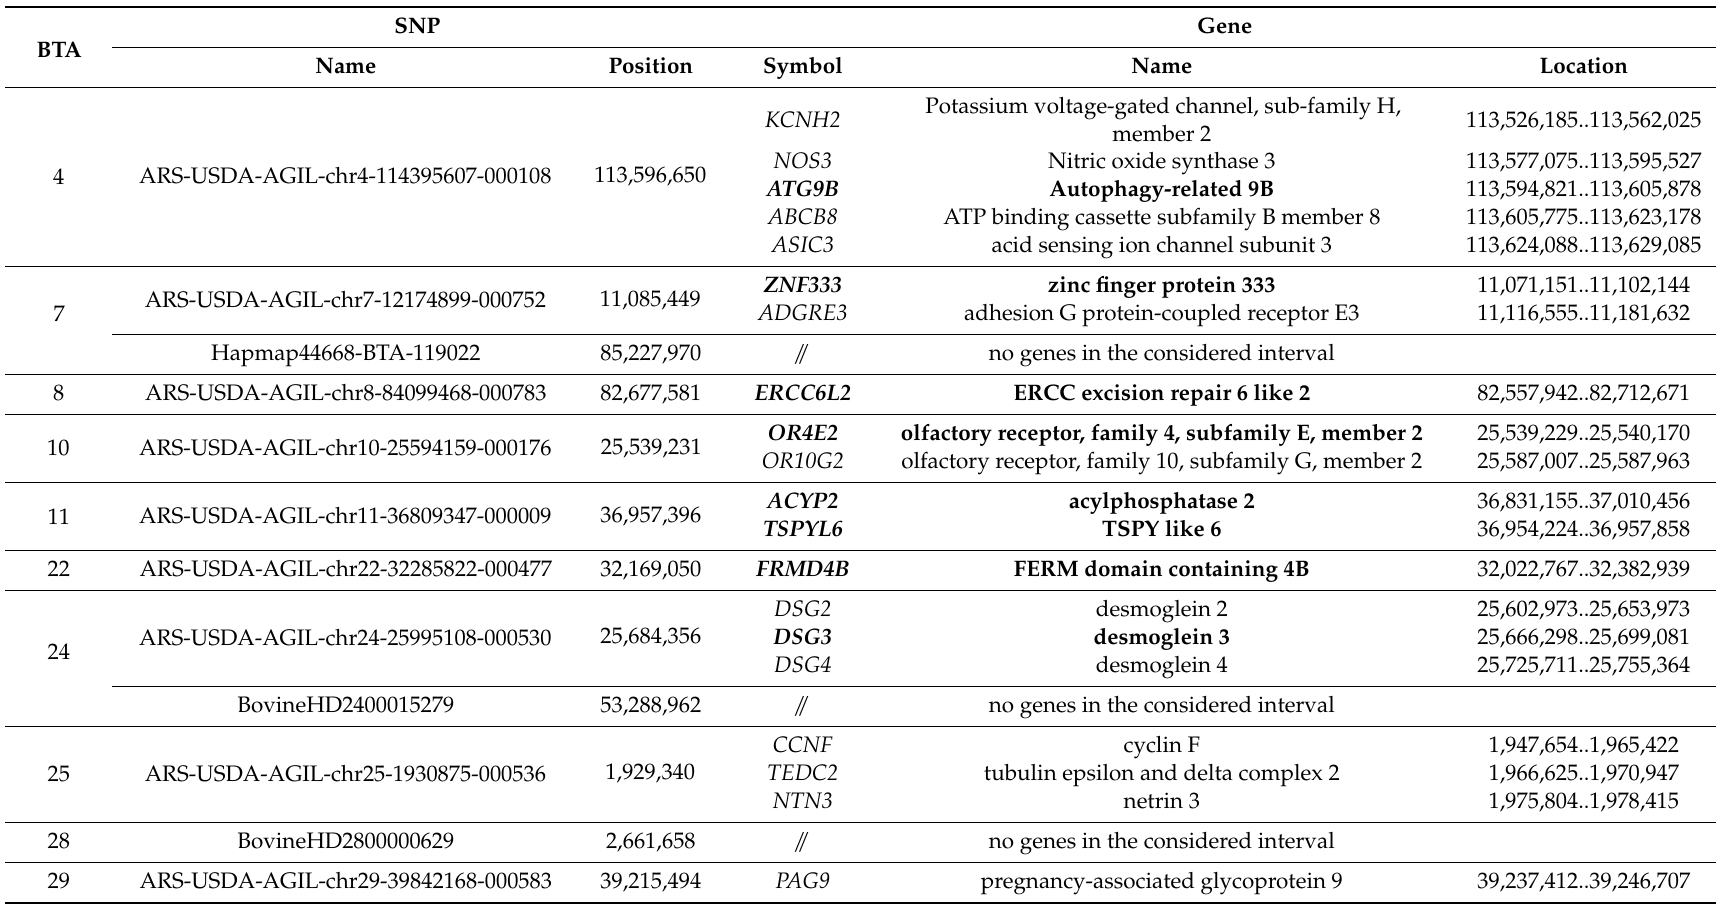
Table 2. Genes near the SNPs associated to arthrogryposis. The genes including a marker are in